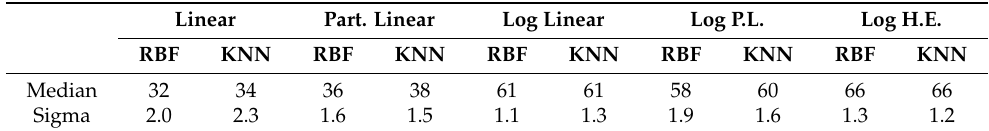
Table 6. F1 score results of the test series with image moments. Linear Part. Linear Log Linear Log P.L. Log H.E.